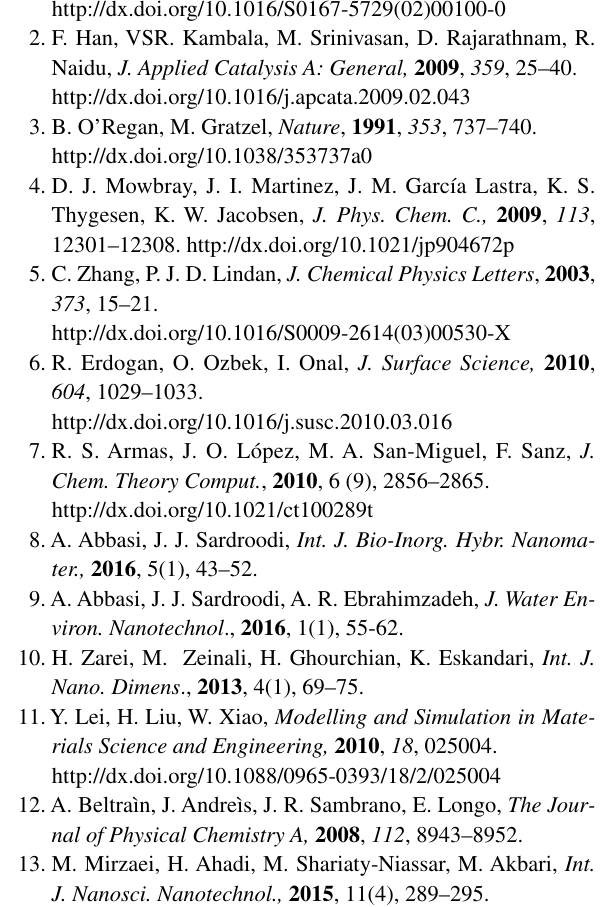
H O molecule adsorbed on the TiO 3 4